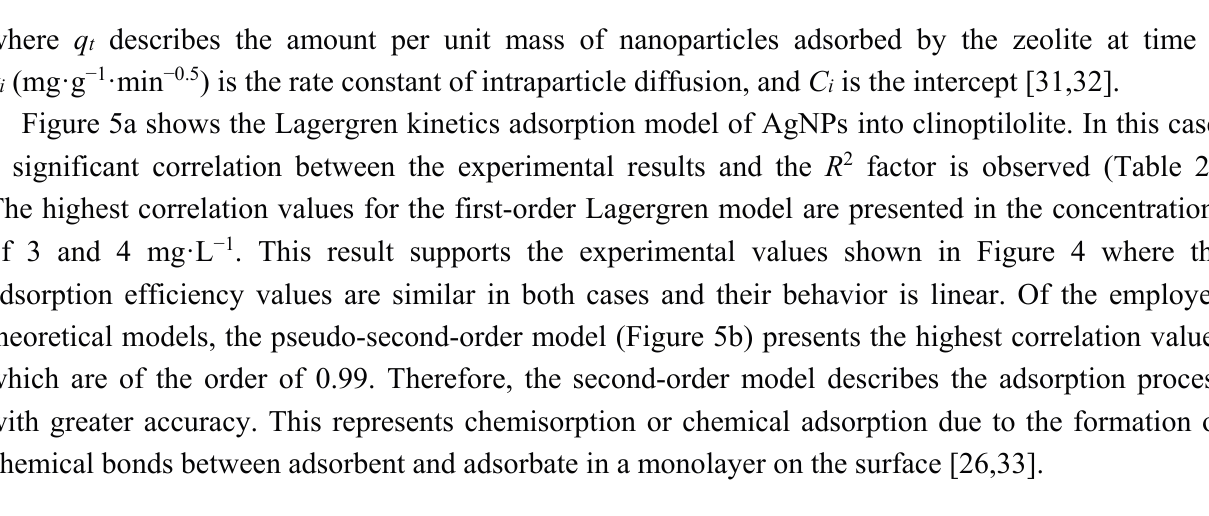
Table 2. Kinetic parameters obtained from theoretical adsorption